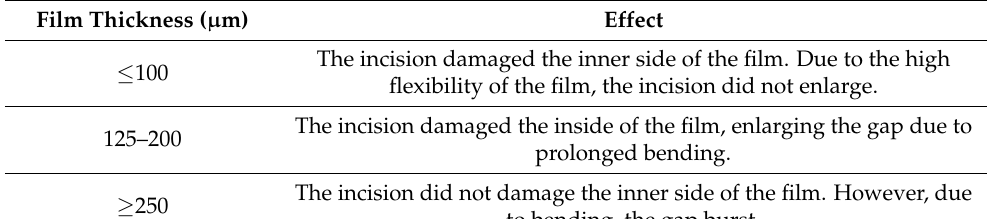
Table 1. Incision test results.